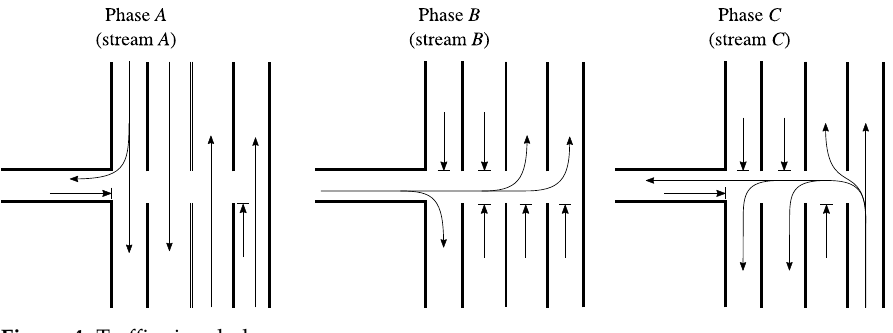
Figure 4. Traffic signal